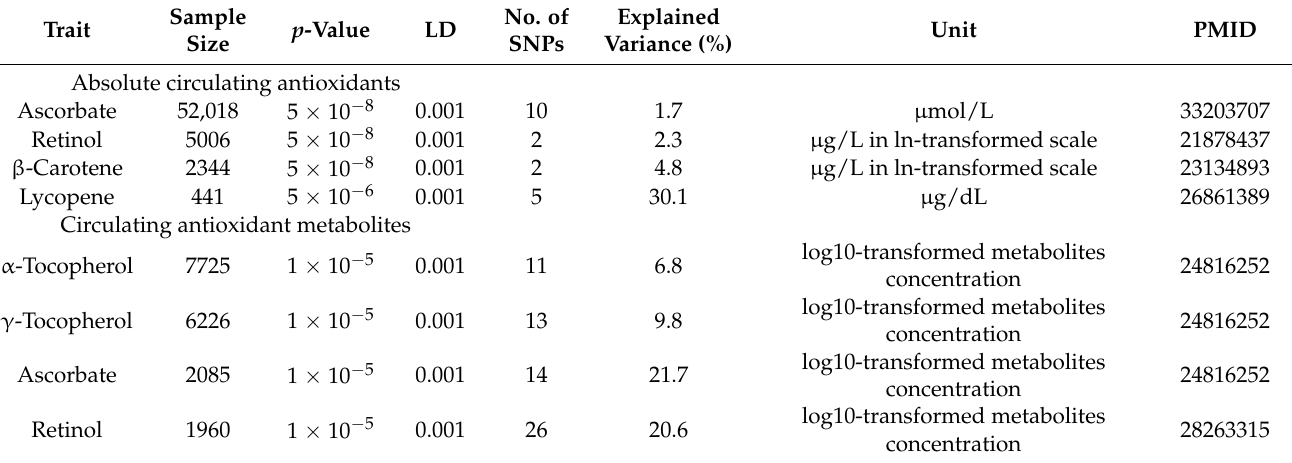
Table 1. The summary of instrumental variables for diet-derived absolute circulating antioxidants and antioxidant